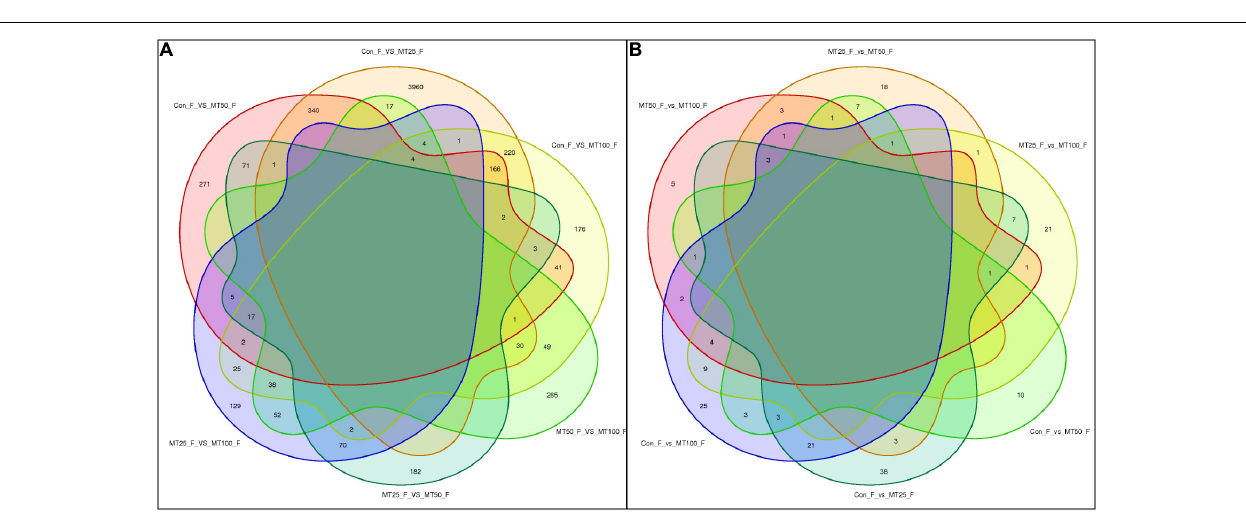
Frontiers in Genetics |